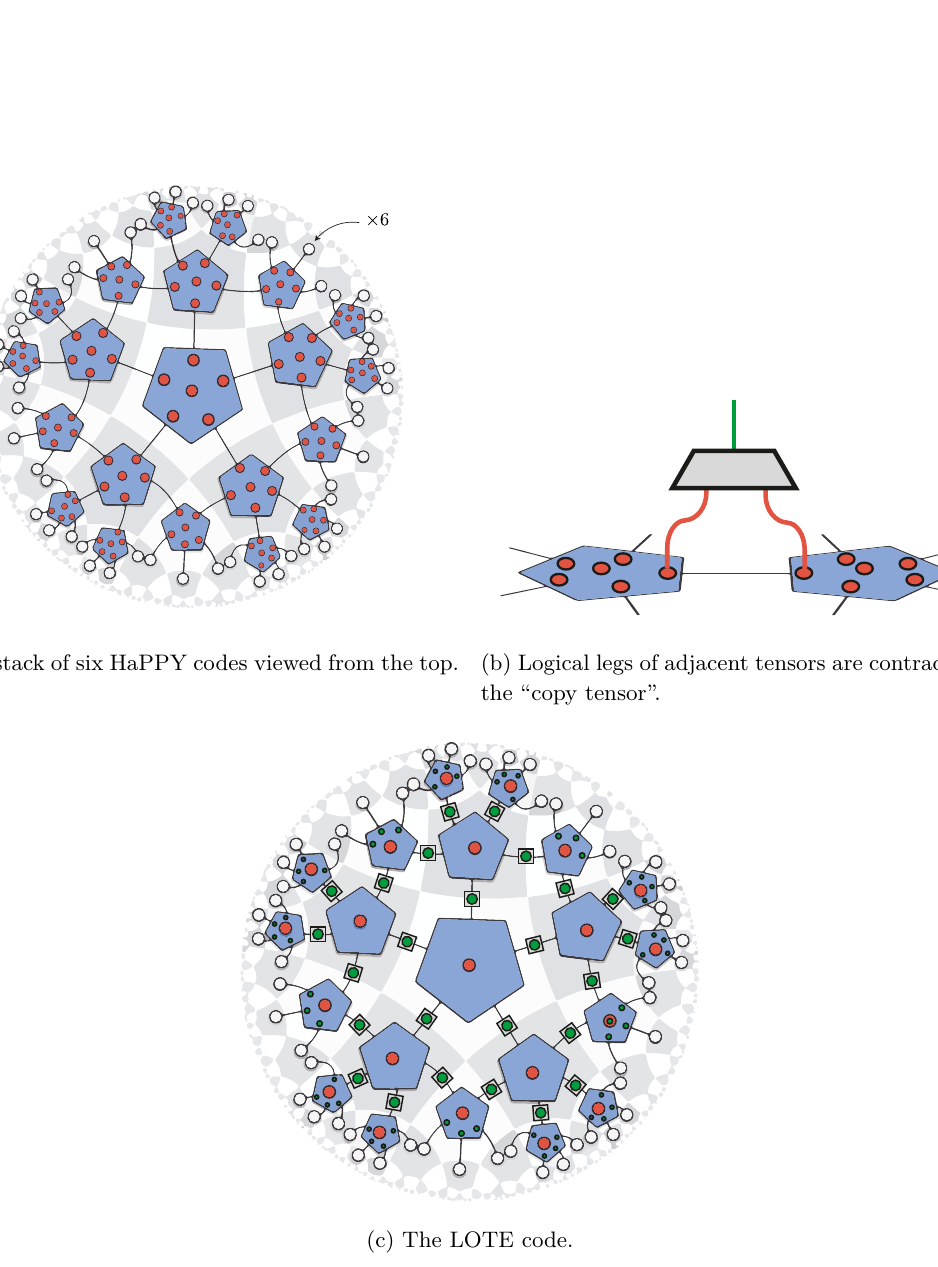
Figure 9. Steps in the construction of the LOTE code. (a) Six HaPPY codes are stacked. The input legs are arranged to clarify how they are contracted. (b) Each pair of input legs from two adjacent tensors is contracted with the copy tensor to create the edge degree of freedom. (c) Final result: the LOTE code. Edge degrees of freedom are represented by green dots. The ones inside grey boxes came from the contractions. The small ones on the boundary tensors correspond to the dangling edge degrees of freedom, and come from uncontracted input